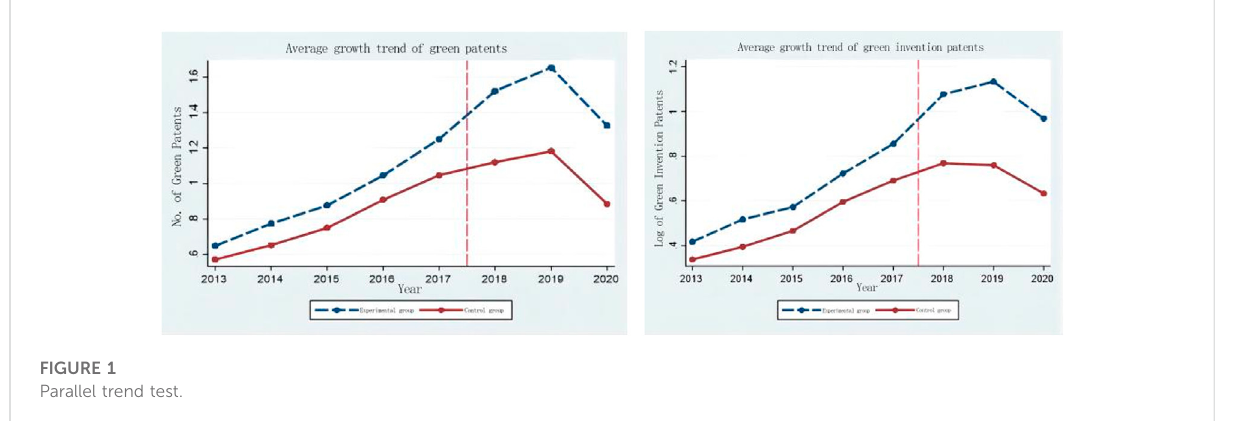
FIGURE 1 Parallel trend test.